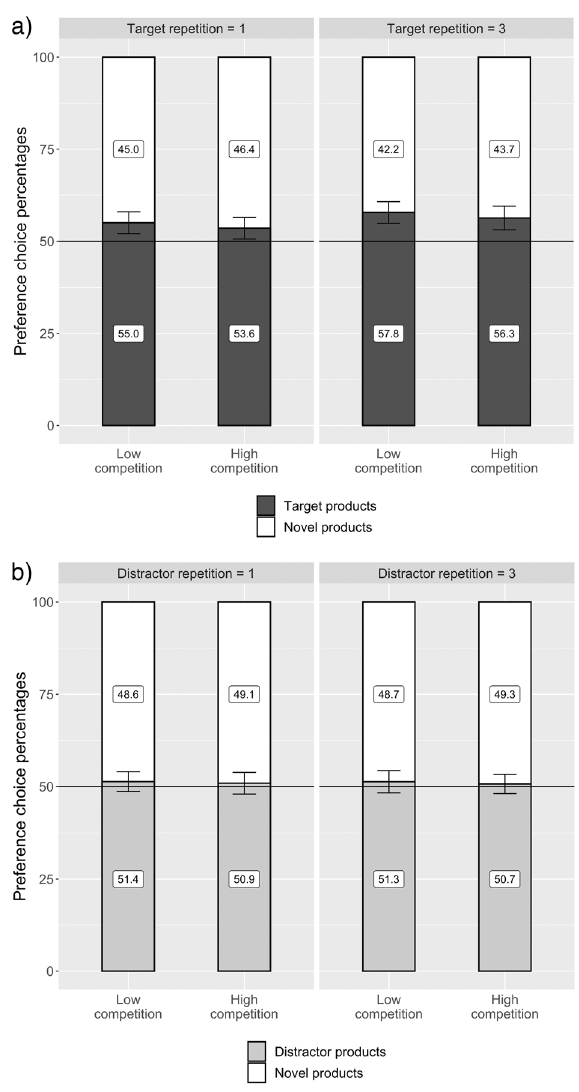
Figure 1. Preference choice percentages (Experiment 1). Preference choice percentages of the two-alternative forced-choice tasks in Experiment 1 for ( a ) target products and ( b ) distractor products. Error bars show 95% confidence intervals.